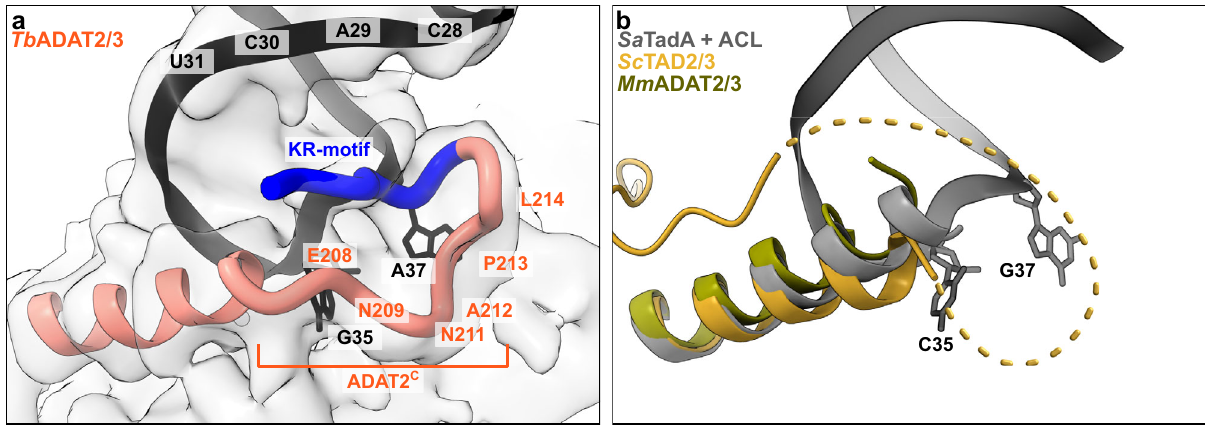
Fig. 4 | The ADAT2 C-terminal region including the KR-motif. a The C-terminus of ADAT2 embraces nucleotides 35 and 37 and KR-loop residues (K or R) provide additional contacts with the anticodon-stem loop via phosphate backbone interac- tionsatresidues28 – 31.AcartoonrepresentationoftheADAT2C-terminusandtRNA